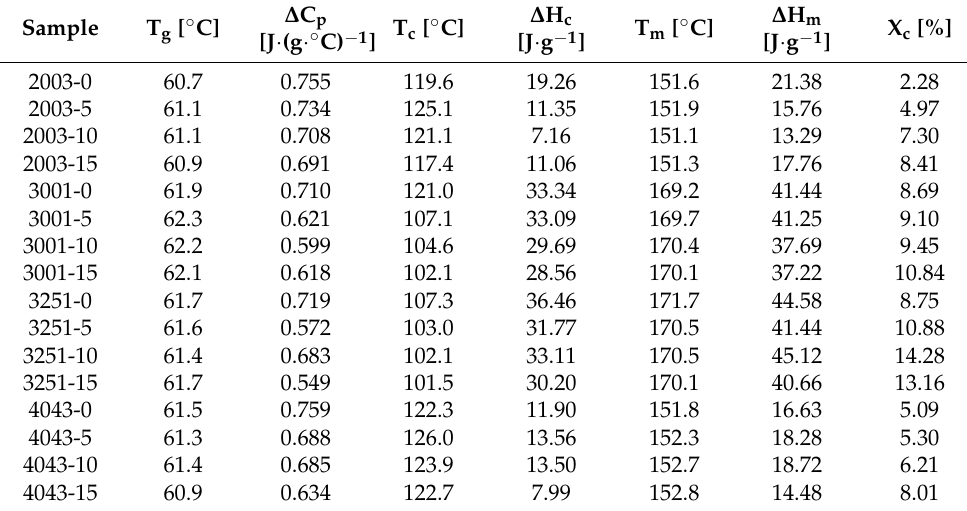
Table 2. DSC results for the PLA and the PLA–DE composites.